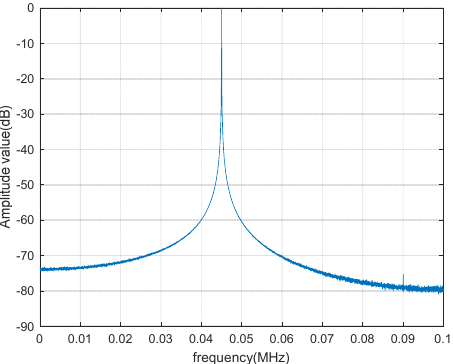
Figure 6. Spectrum of an incoherently sampled ADC using direct DFT ( N DATA = 16,384, C WIN = 3686.4).